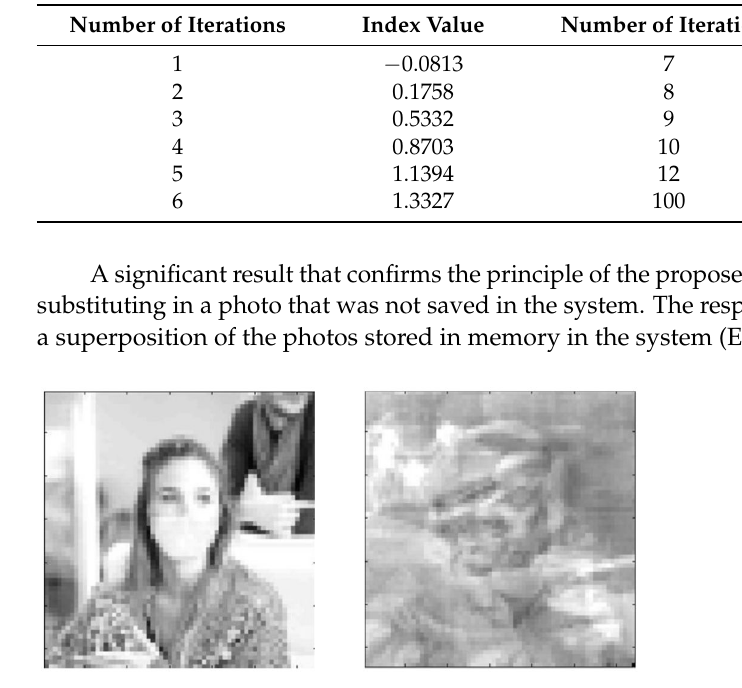
Figure 5. Attempt to recognize an unsaved